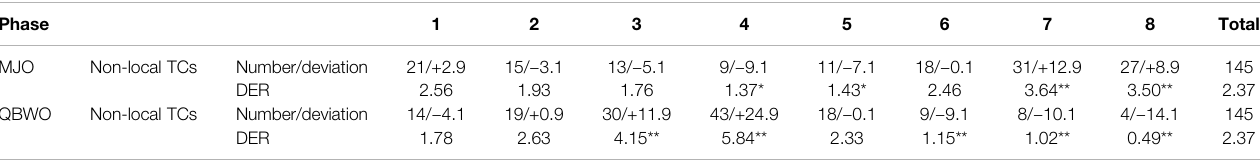
TABLE 1 | The number and daily entering rate (DER) of nonlocal TCs in each phase of MJO and QBWO phase.